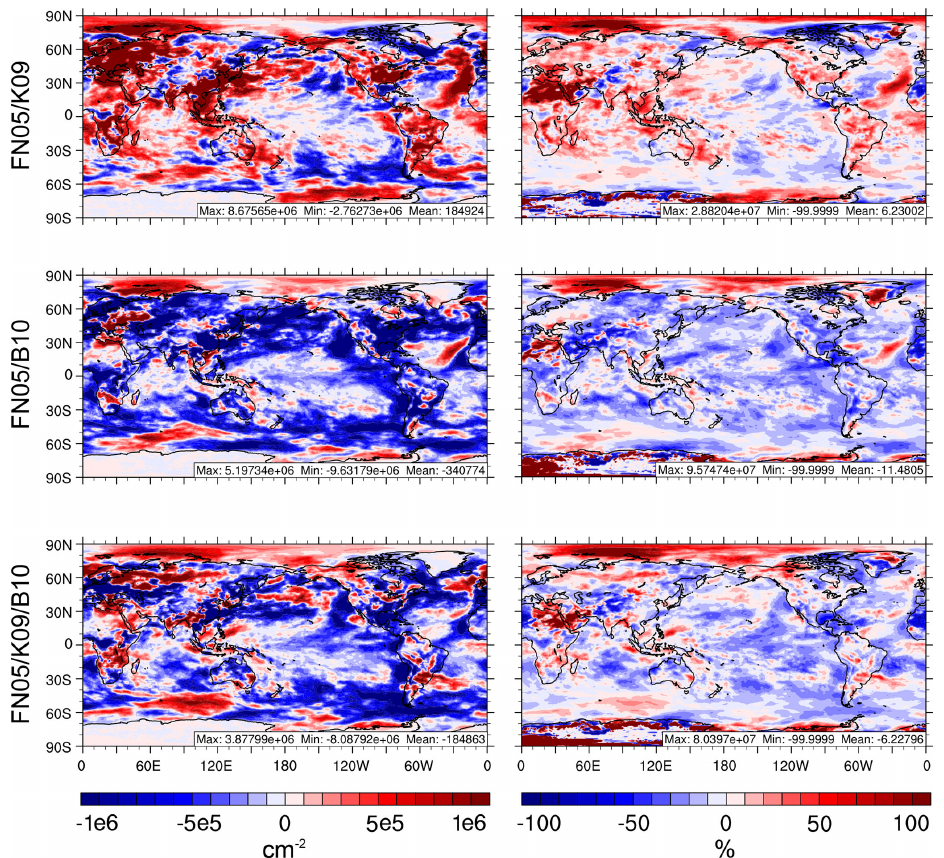
Figure 5. Annual-average absolute (left, in units of cm − 2 ) and percentage (right) change in column CDNC from FN05 to each of the FN05 updates in CESM/CAM5. The global mean percentage change values are calculated from the averaged absolute change rather than the average of the gridded percentage changes. Note that the color bar range for the left column is a factor of 5 less than that of Figure 4 (top left) to better show spatial